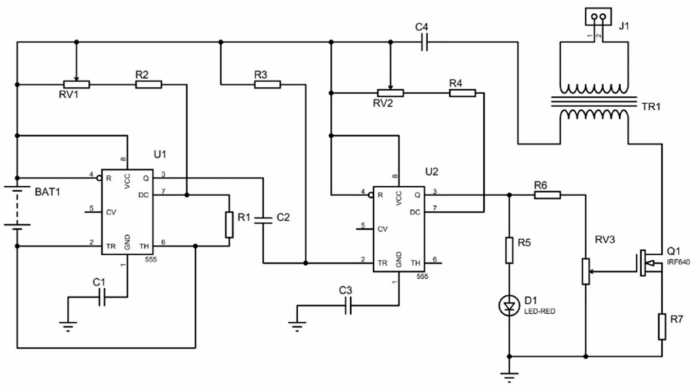
Figure 13. TENS Circuit.